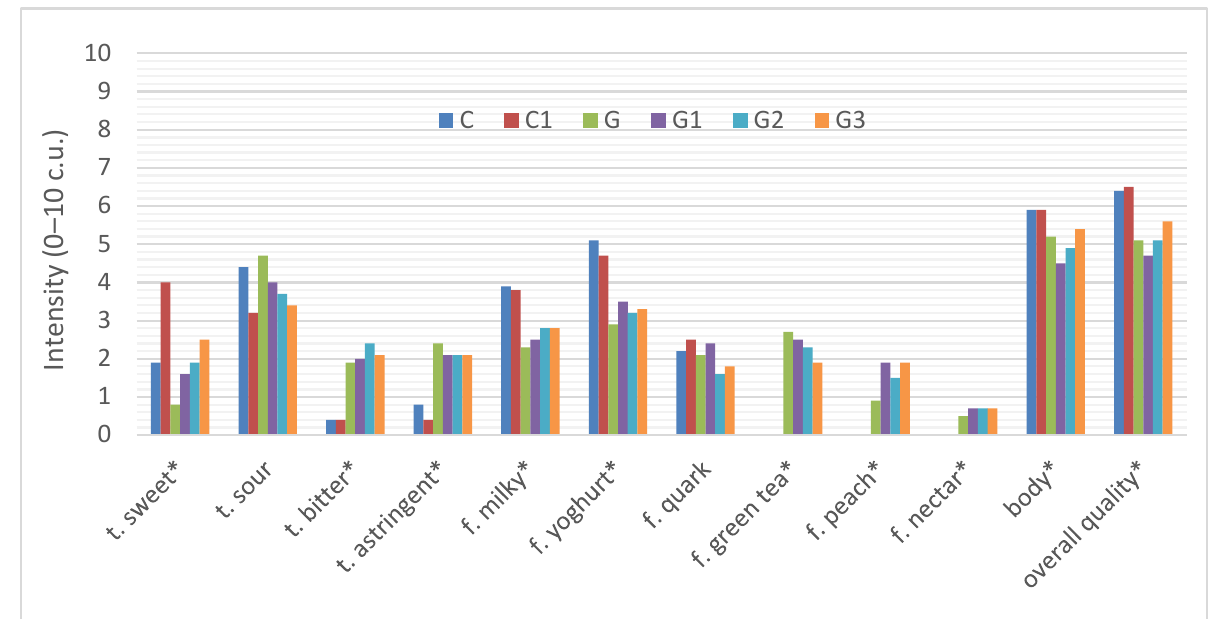
Figure 4. Sensory profile of the taste/flavor/overall quality of yoghurts C, C1, G, G1, G2. The abbreviations in the figure refer to the control sample (C), control yoghurt with 6% inulin (C1), yoghurt with green tea (G), yoghurt with green tea and 3% inulin (G1), yoghurt with green tea and 6% inulin (G2), yoghurt with green tea and 9% inulin (G3) (t—taste, f—flavor; * significantly differed at p ≤